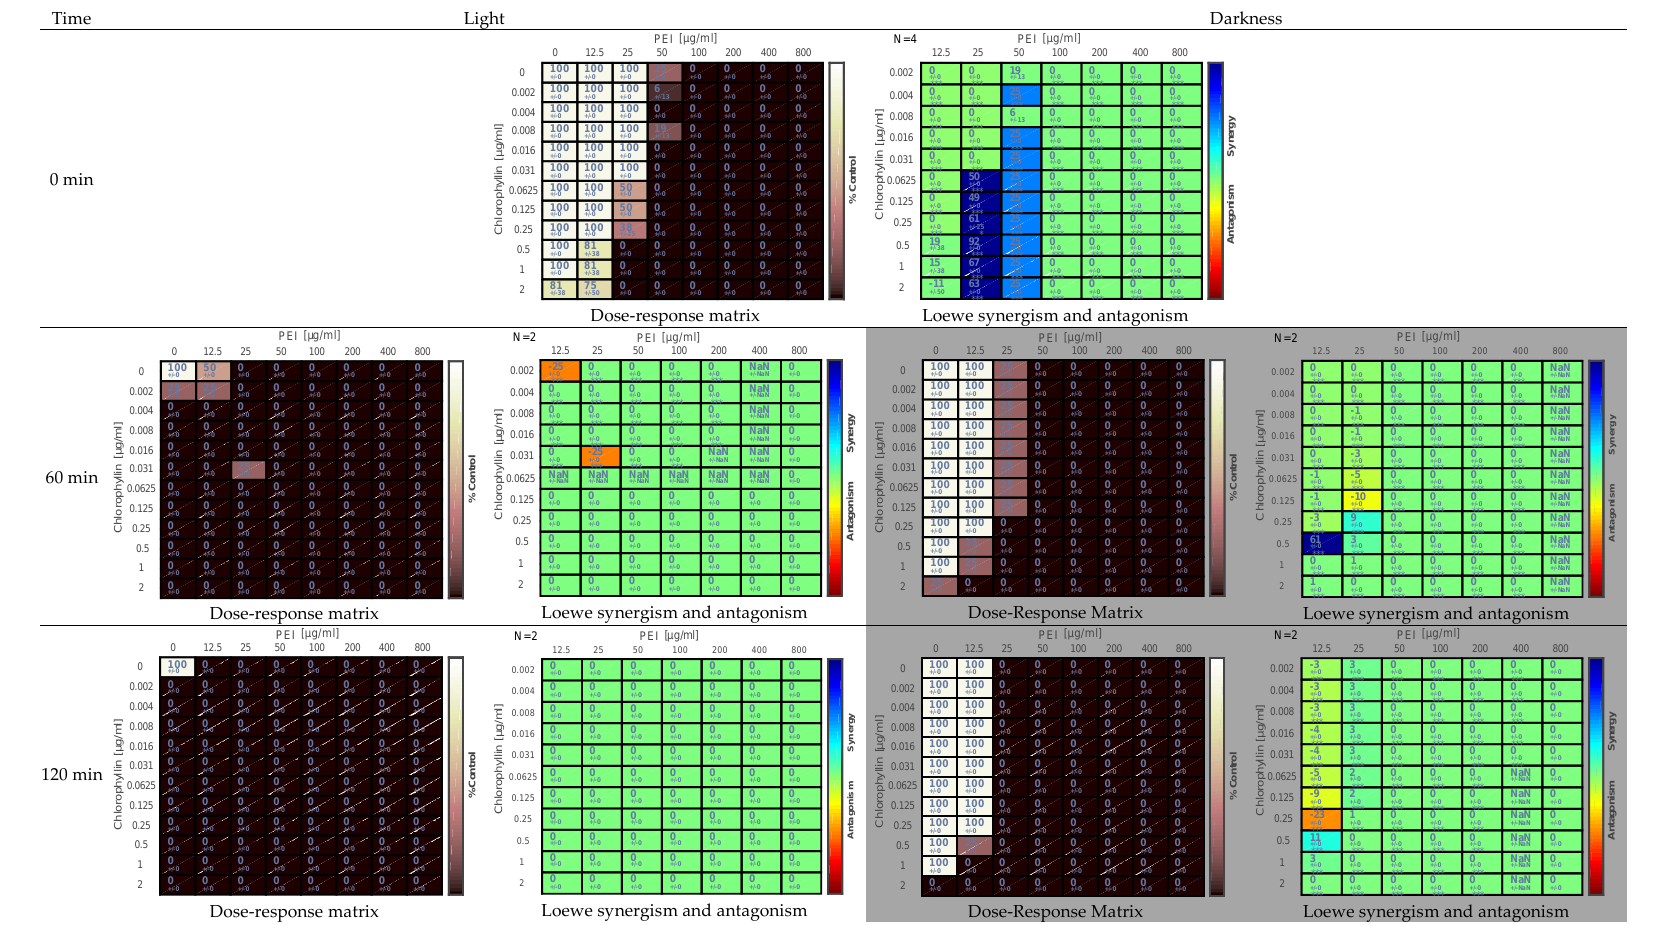
Figure 3. Effect of PEI and chlorophyllin combinations on Bacillus subtilis 168 upon illumination with a blue-red light source (12.7 mW cm − 2 ) and in darkness at 0 min, 60 min, and 120 min of incubation. The dose-response matrix indicates the percentage of eradication (the darker the color, the higher the inhibitory effect). The Loewe synergism and antagonism for PEI-chlorophyllin combinations against B. subtilis 168 were determined using the Combenefit software. N represents the number of biological replicates in the matrix. Asterisks represent statistical significance: ***: p <